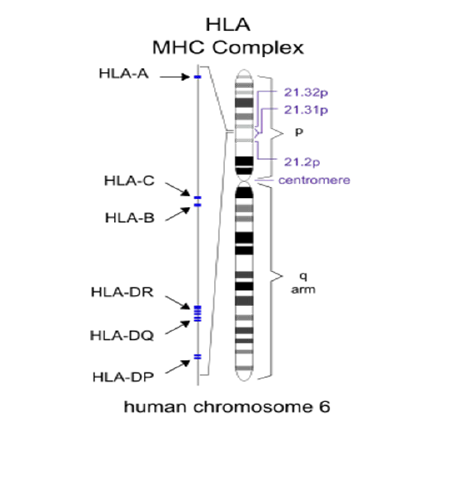
Figure 1. Structure of a HLA MHC Complex